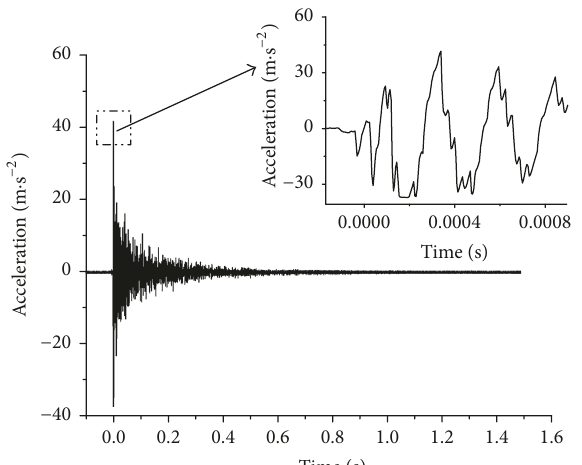
Figure 4: Vibration acceleration signal at outer surface of explosive